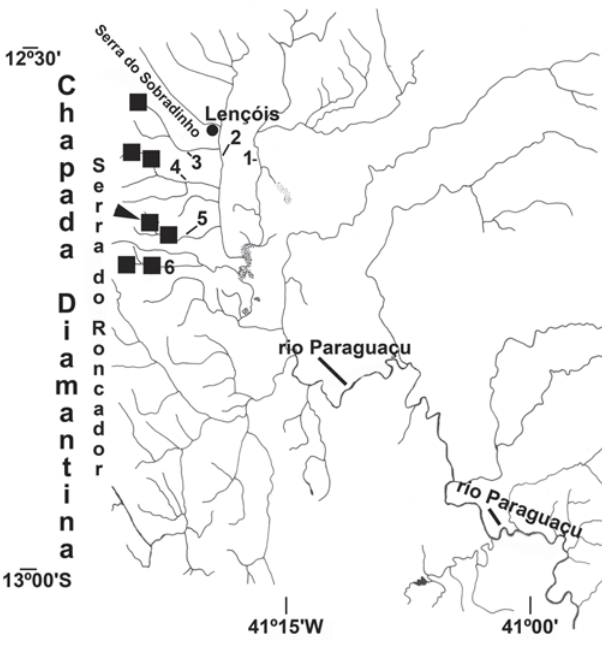
Fig. 6. Map of upper course of rio Paraguaçu showing the distribution of Aspidoras psammatides (squares). 1: rio Santo Antônio; 2: rio São José; 3: rio Ribeirão; 4: rio Capivara; 5: rio Caldeirão; 6: rio Roncador; arrow: type